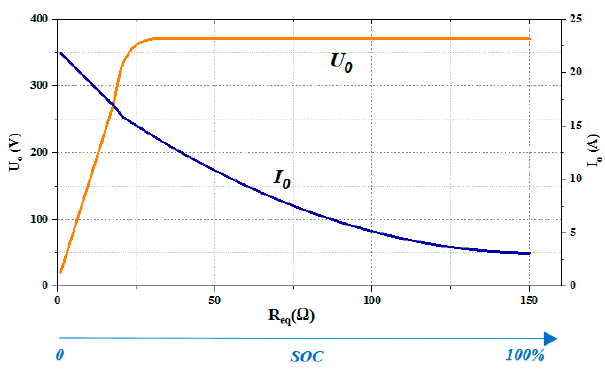
Figure 17. Theoretical output curves of system.